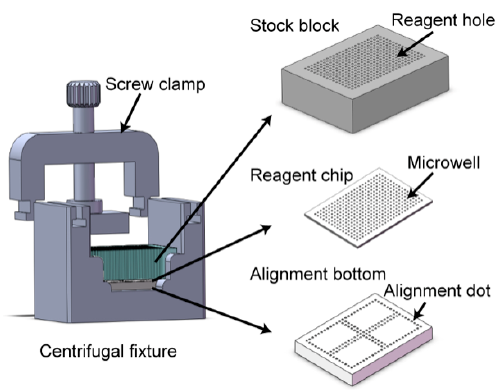
Figure 2. Schematic of the nanoliter centrifugal liquid dispenser (NanoCLD). Assembly of the NanoCLD consisting of four parts: a stock block, a reagent chip, an alignment bottom, and a centrifugal fixture. A screw clamp was employed to hold these parts together in the fixture during centrifugation.